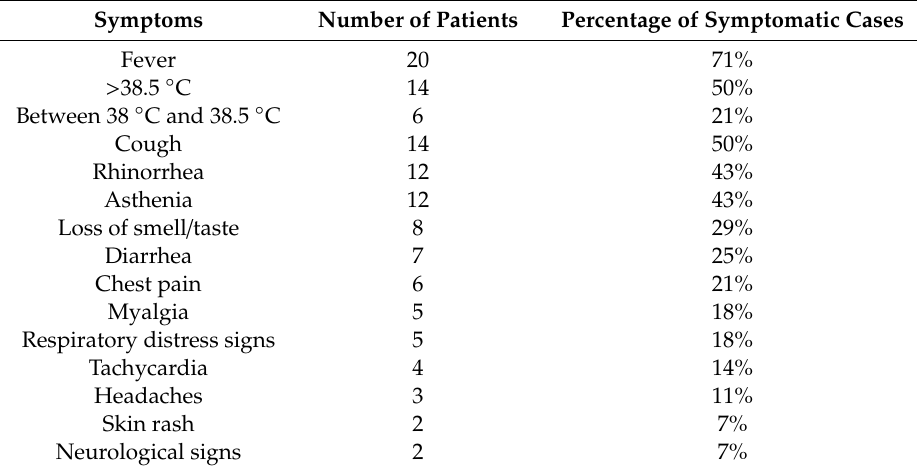
Table 2. Clinical signs of COVID-19 among the 28 symptomatic